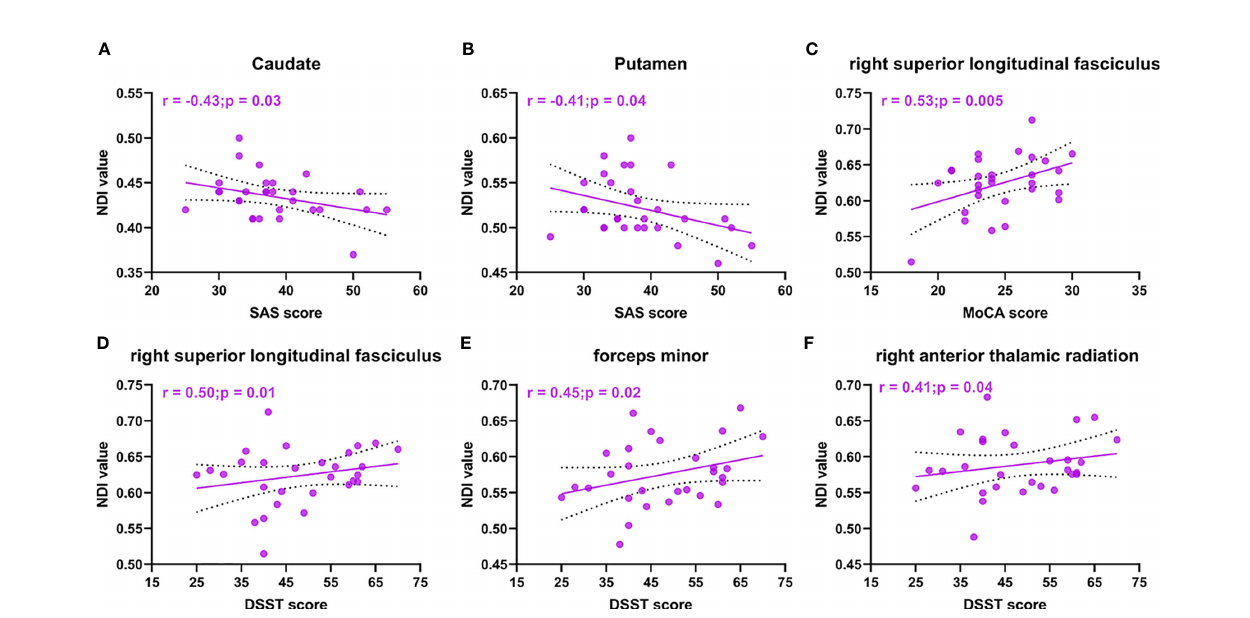
FIGURE 5 | NODDI metrics correlations with neuropsychological disorders in acromegaly. Cortical NDI in caudate (A) and putamen (B) are negative correlation with SAS score. NDI in right superior longitudinal fasciculus are positive correlation with MoCA score (C) and DSST score (D) . NDI in forceps minor (E) and right anterior thalamic radiation (F) were positively correlated with DSST score.